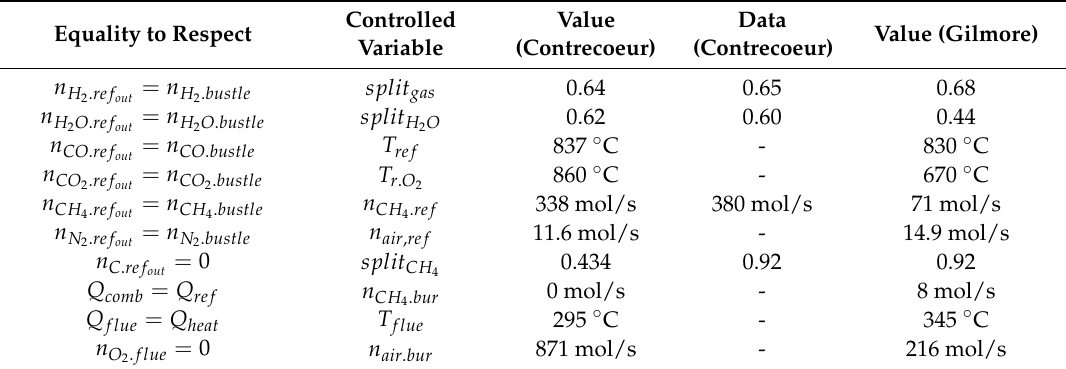
Table 4. Design specifications, controlled variables and corresponding